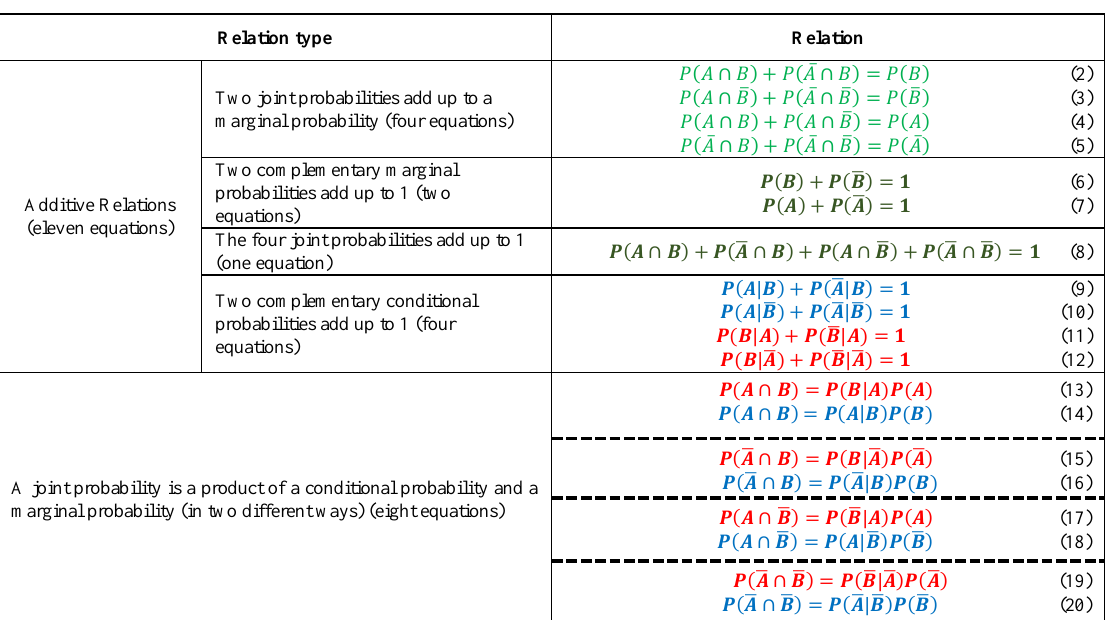
Table 1. The 19 redundant relations of ternary problems of conditional probability in the contingency table context (classified according to relation type) Relation type Relation Two joint probabilities add up to a marginal probability (four